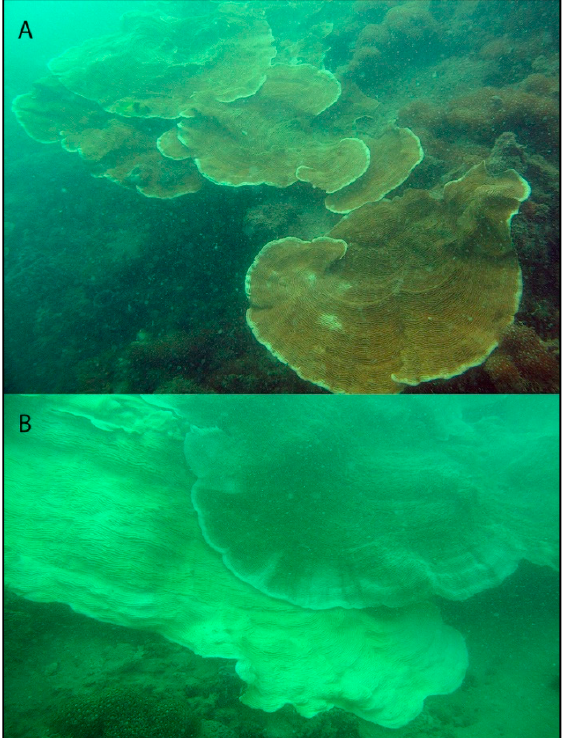
Figure 1. Pachyseris speciosa at Pulau Hantu in June 2016. ( A ) Healthy colony. ( B ) Bleached colony showing both bleached and non-bleached tissues.